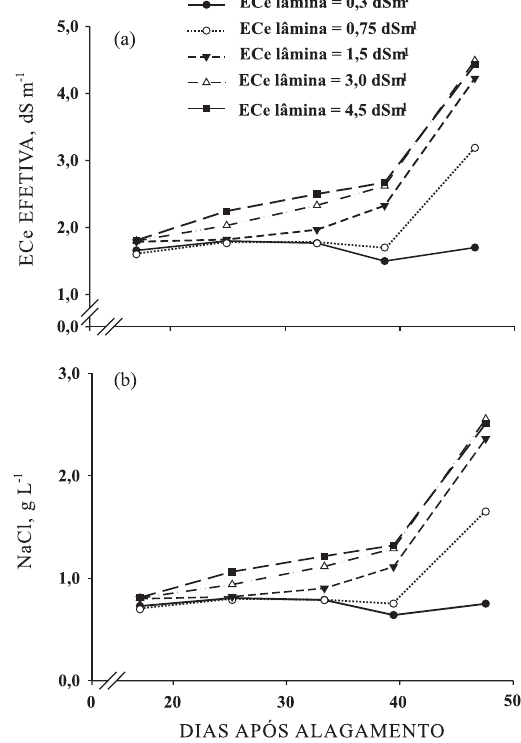
Figure 1. Effective electrical conductivity - ECe (a) and content of sodium chloride (b) of the soil solution throughout rice development according to the electrical conductivity of the water layer